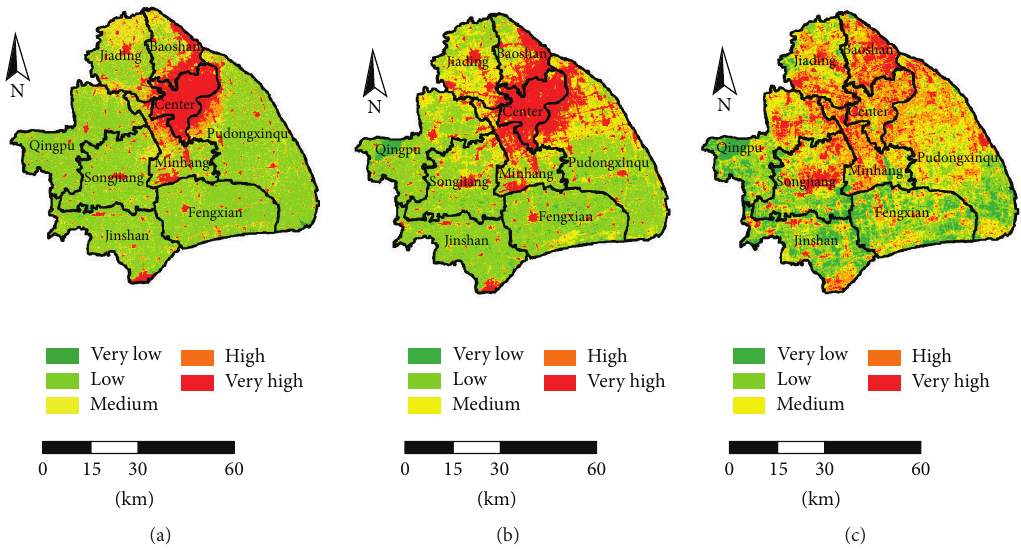
Figure 2: The LST distribution for Shanghai: (a) 1989, (b) 2000, and (c) 2013.